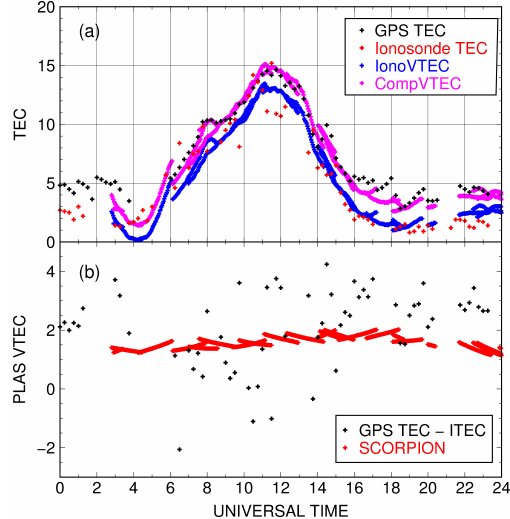
Figure 7. (a) Ionosonde vertical TEC (red), BC/ISR GPS vertical TEC (above 60 ◦ elevation; black), SCORPION composite vertical TEC (above 60 ◦ elevation; “CompVTEC”, pink), and SCORPION ionosphere-only vertical TEC (above 60 ◦ elevation; “IonoVTEC”, blue); (b) BC/ISR GPS vertical TEC minus ionosonde vertical TEC (black) and SCORPION plasmasphere-only vertical TEC